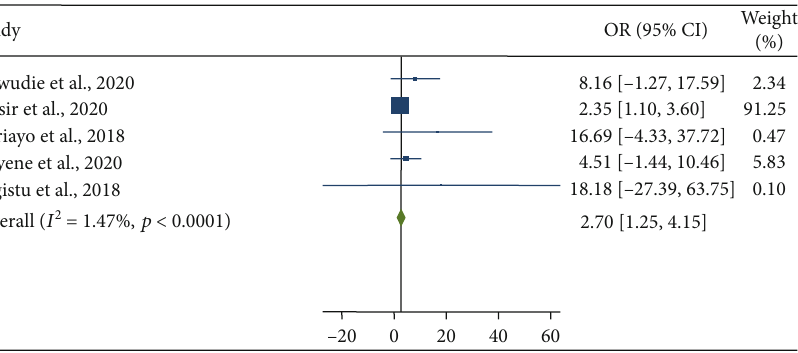
Figure 6: Forest plot depicting pooled random-e ff ect size (OR) of